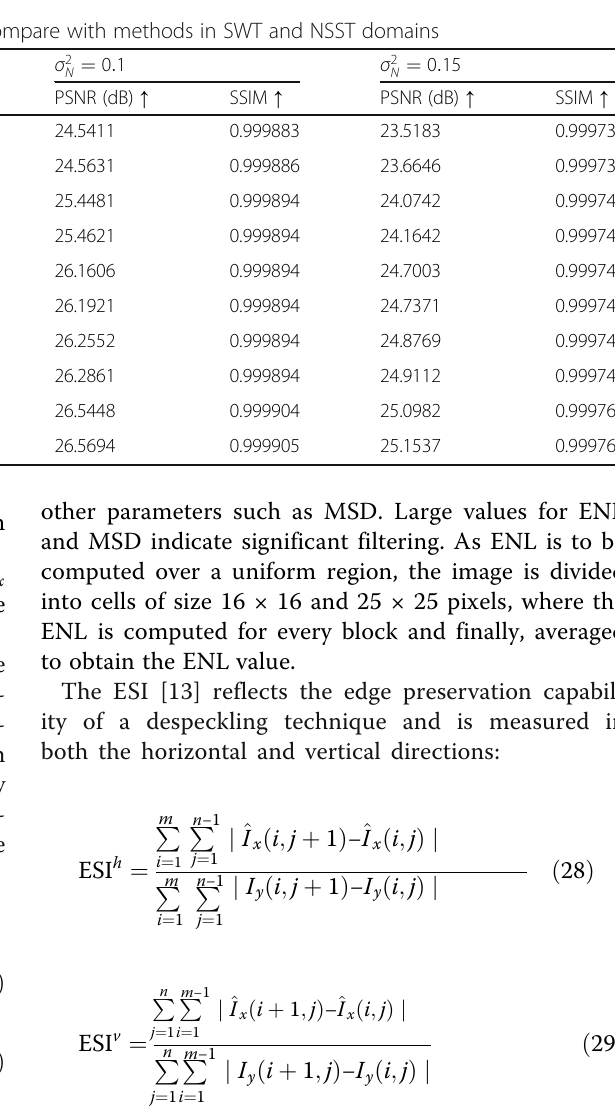
Table 2 Two objective assessment parameters for Barbara to compare with methods in SWT and NSST domains